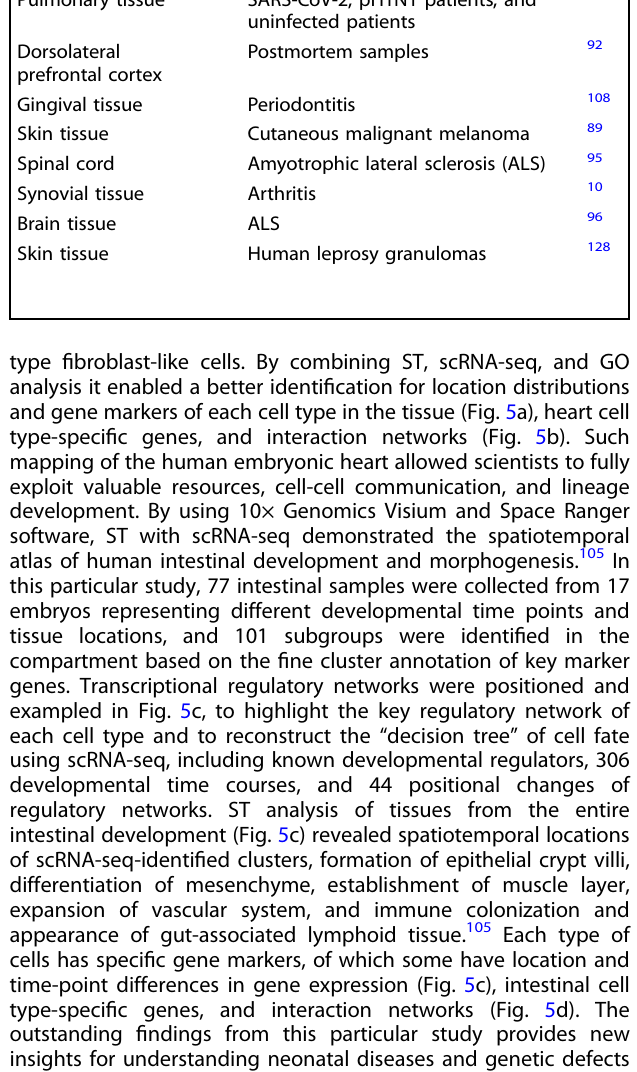
includes molecular codes for mapping and targeting discrete neuroanatomical domains. 101 ST in embryo development Embryos and stem cell lineages serve as paradigms to explore the tissue patterning and corresponding molecular regulation circuits. ST with scRNA-seq have opened up new ways for dissecting molecular dynamics of cell organization, differences in morphol- ogy and molecular properties, and lineage allocation during the process of embryo development. 102 The process of somitogenesis was explored for key features of embryos and development after implantation in mouse gastruloids using ST with scRNA-seq. 103 The comprehensive transcriptional landscape of human embryo- nic heart cell types, cell-type distribution, and spatial organization reveals three developmental stages at 4.5 – 5, 6.5, and 9 post- conception weeks. 104 Using Seurat package for data processing, ST pro fi les of three human embryonic cardiac samples showed about 3,115 individual spots and 10 myocardial clusters during development of human embryonic heart. 104 Spatial maps of cell types, transcriptomes, and spatiotemporal maps of human heart development were obtained from about 69 selected target genes (Fig. 5). scRNA-seq analysis of cardiac embryonic tissue yielded three-types cardiomyocytes, two type endothelial cells, and four-